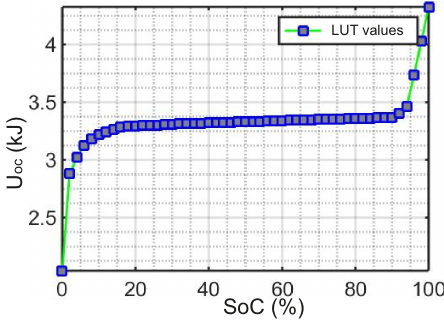
Figure 6. Relation between SoC and